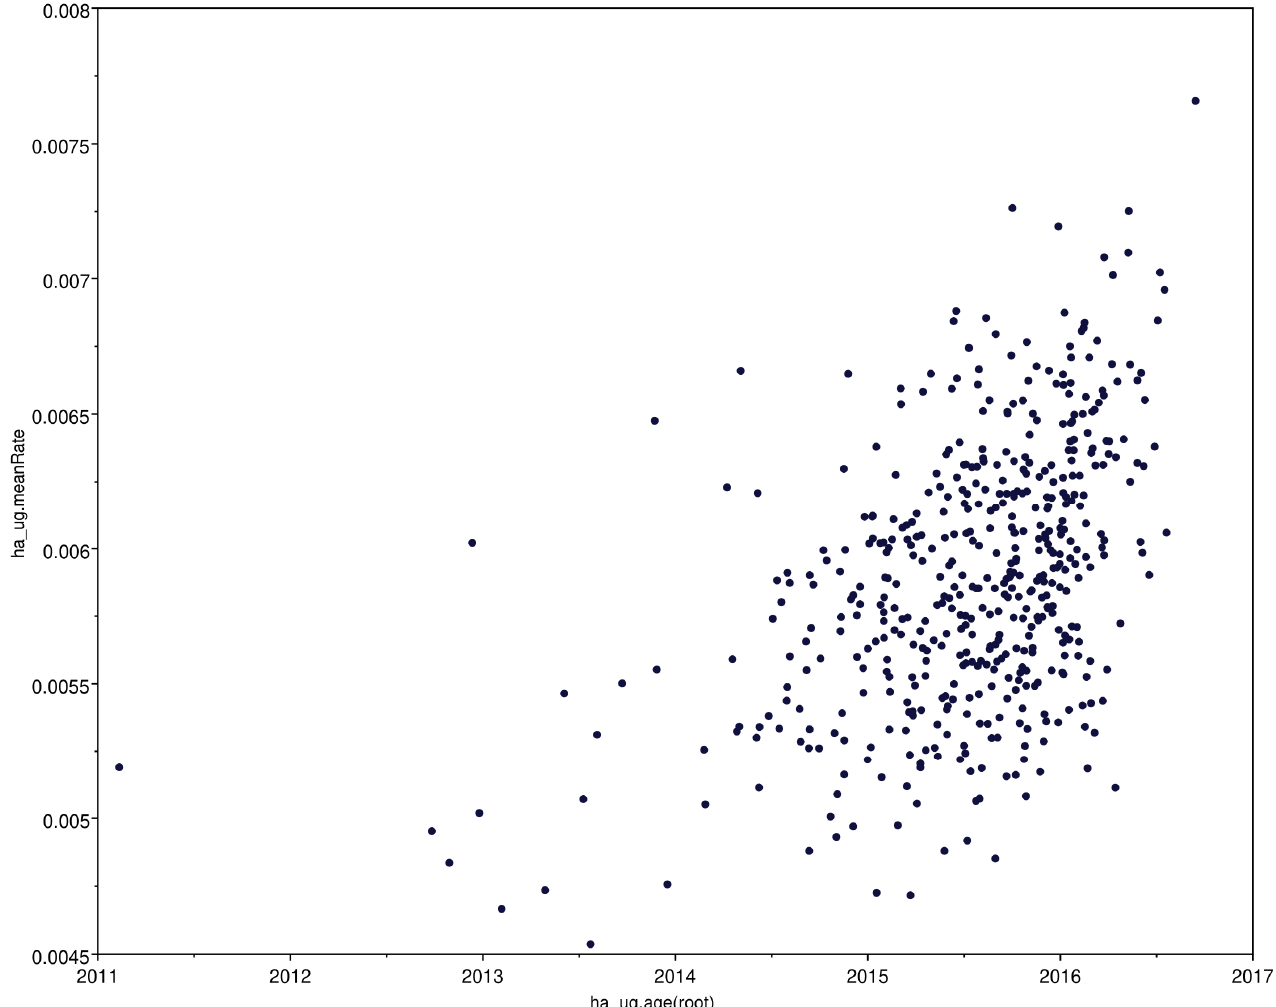
Figure 3. Mean rate of nucleotide substitution per site in the HA segment of Uganda H9N2 viruses over time. Each dot represents a branch in the tree and the age(root) corresponds to time of divergence.